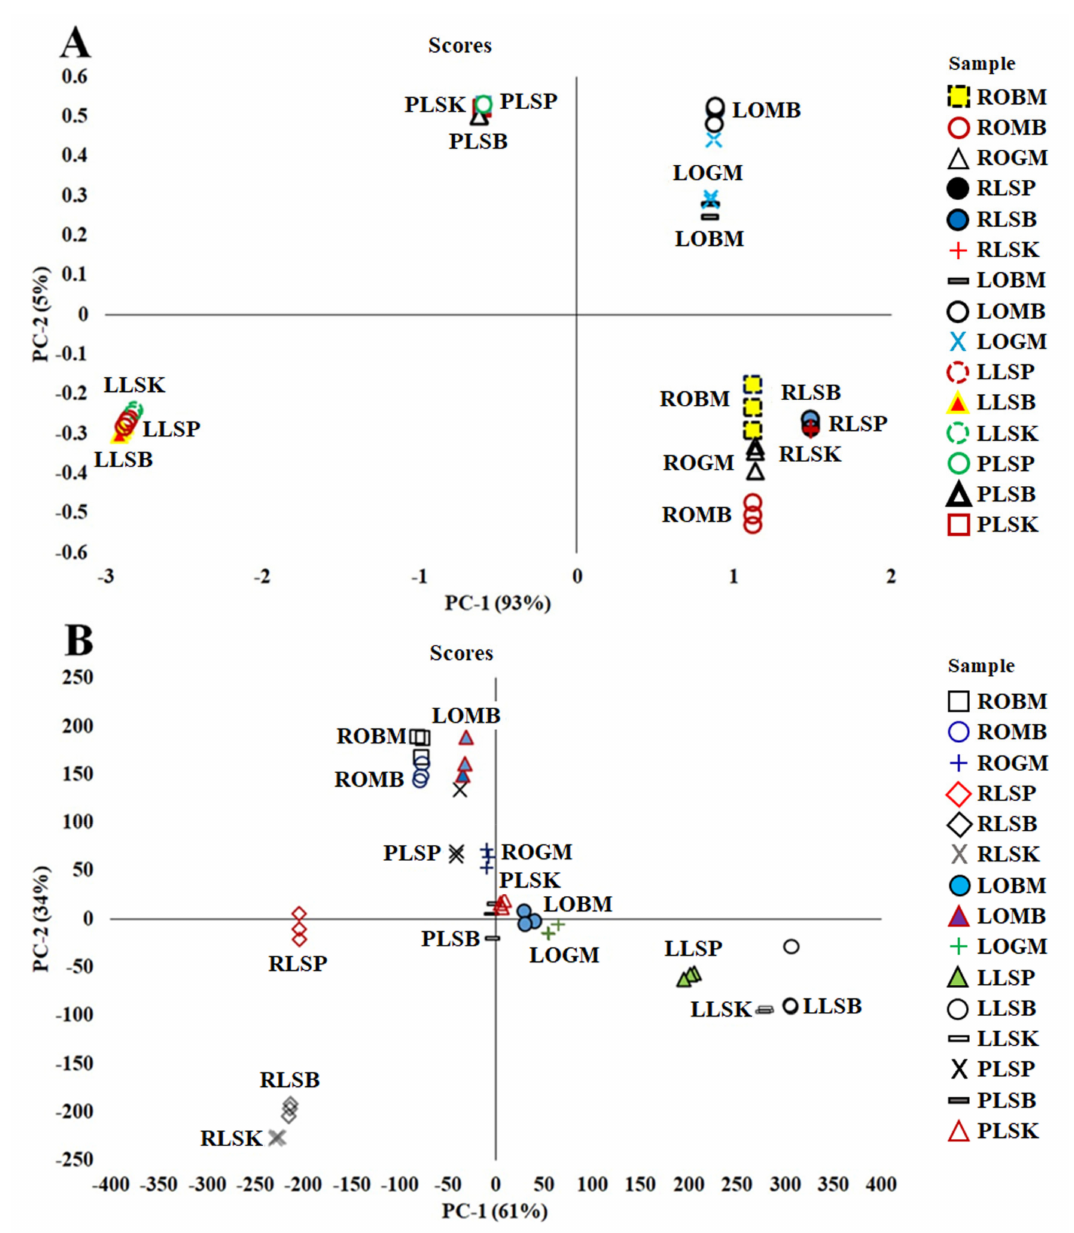
Figure 1. Principal component analysis (PCA) score plot for principal component (PC–1) and (PC–2) in 70% ethanol extract of C. orchioides and C. latifolia using Fourier-transform infrared (FTIR) spectra ( A ) and UHPLC-Q-Orbitrap HRMS ( B